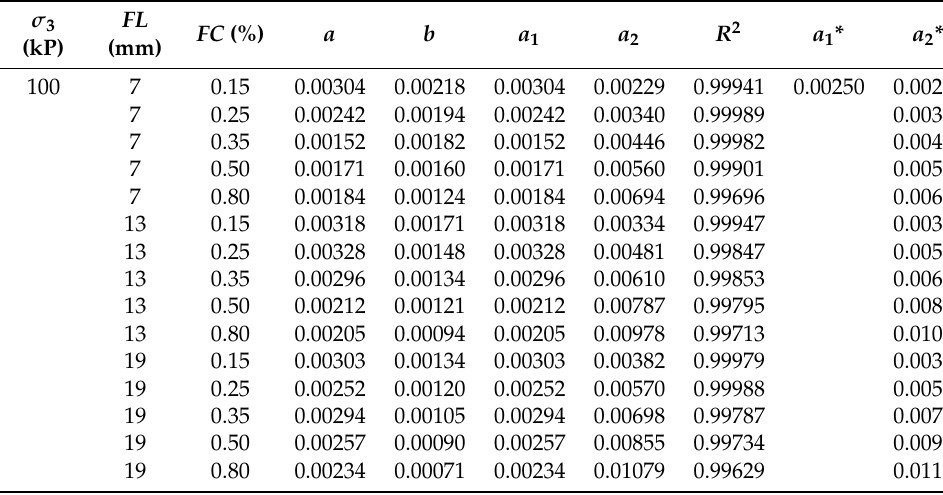
Figure 6. Comparison of measured and predicted results. Table 6. Model parameters under 100 and 300 kPa cell